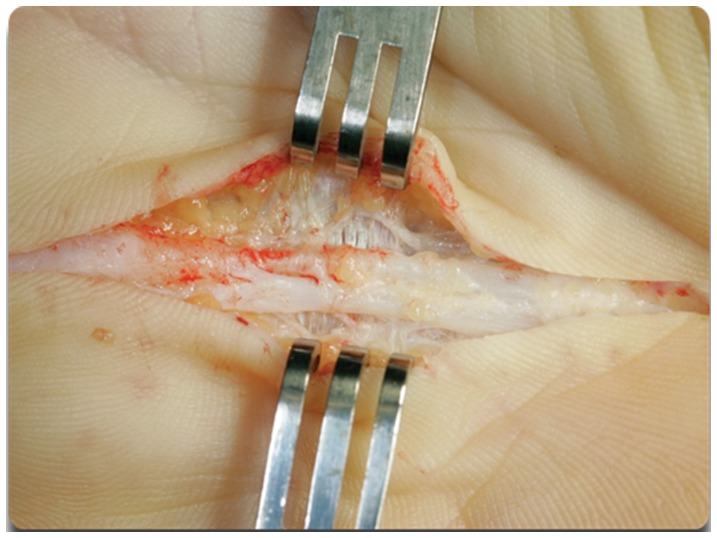
Superficial dissection revealing residual attenuated pretendinous Dupuytren's cord.